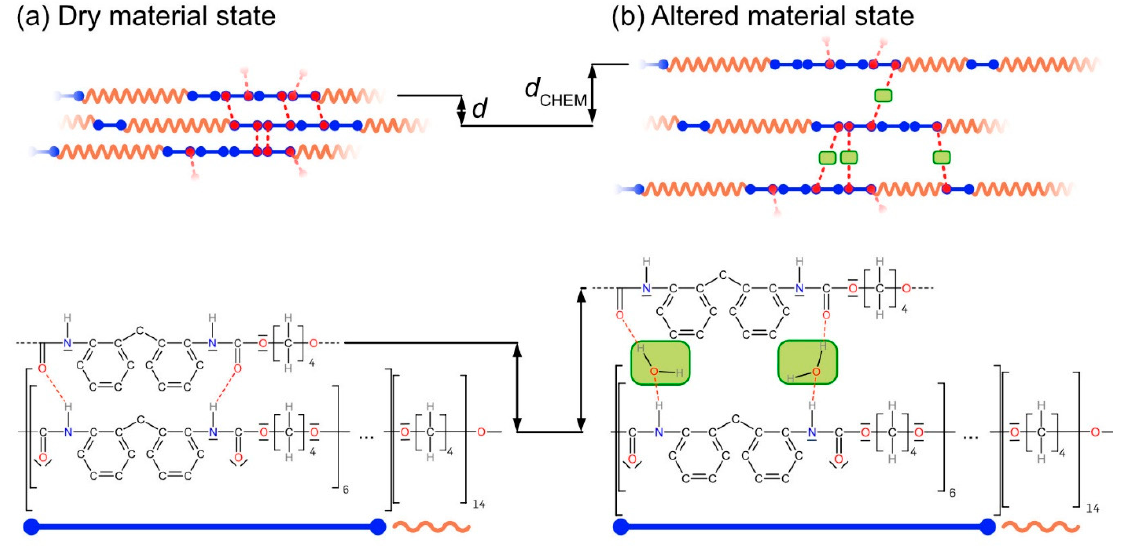
Figure 16. Solvents occupy intermolecular spaces and increase the free volume (schematic illustration). For details, see text.